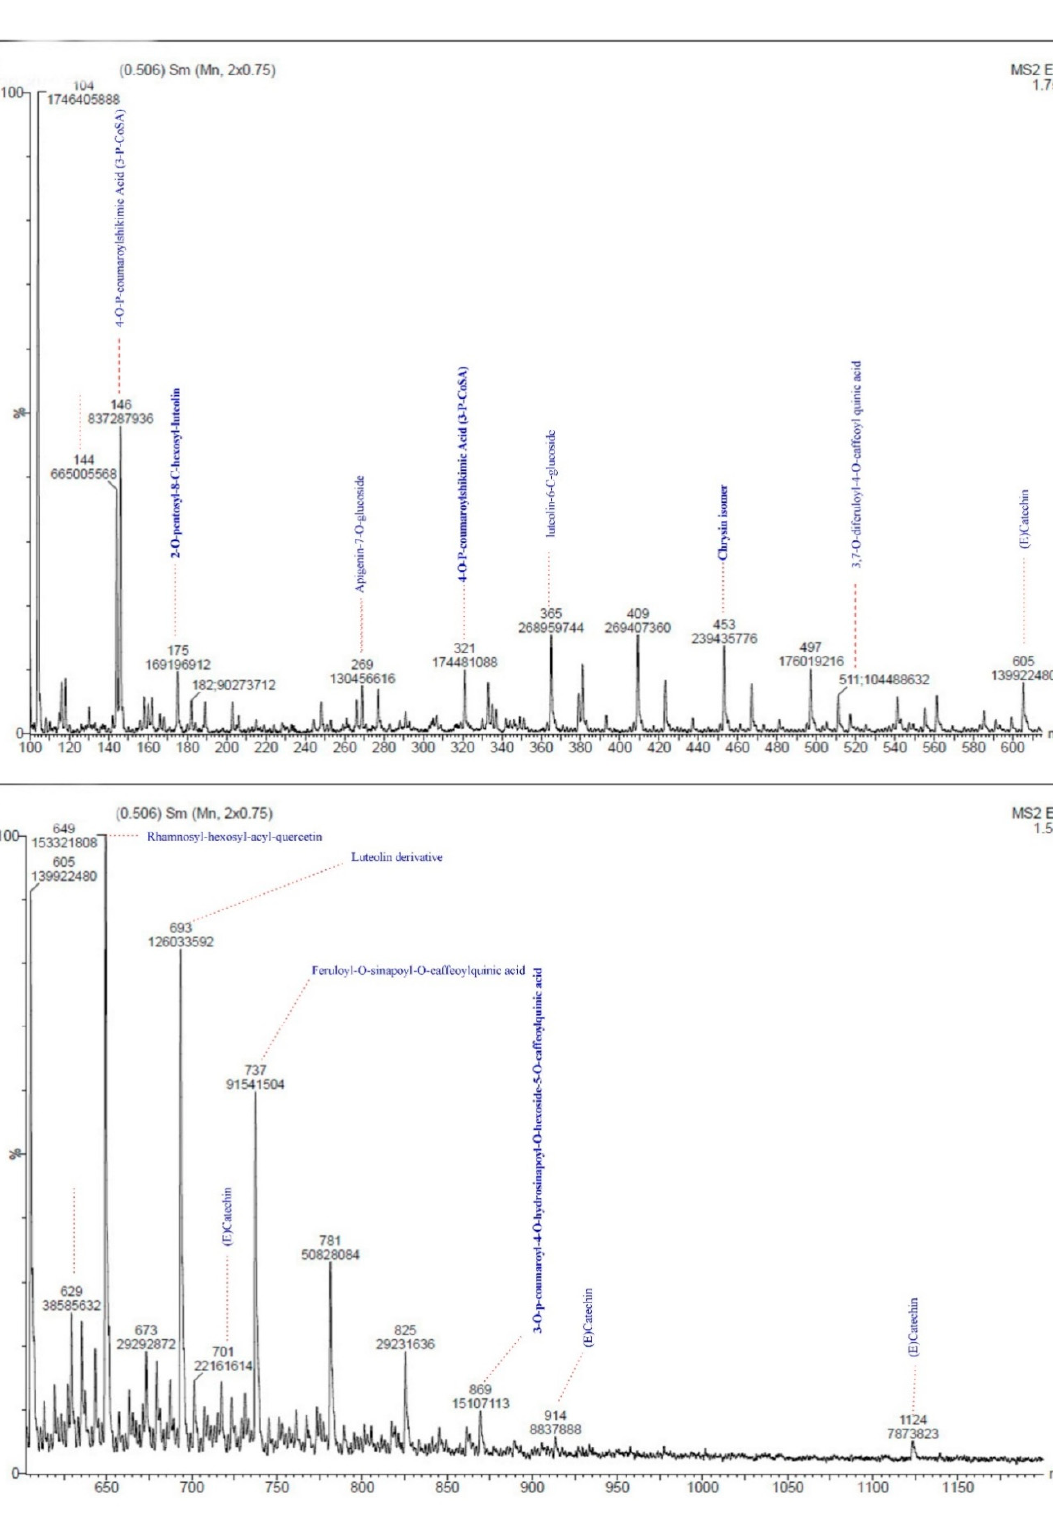
Figure 1. Mass spectrum of red-hot pepper methanolic extract in positive mode for LC-MS.